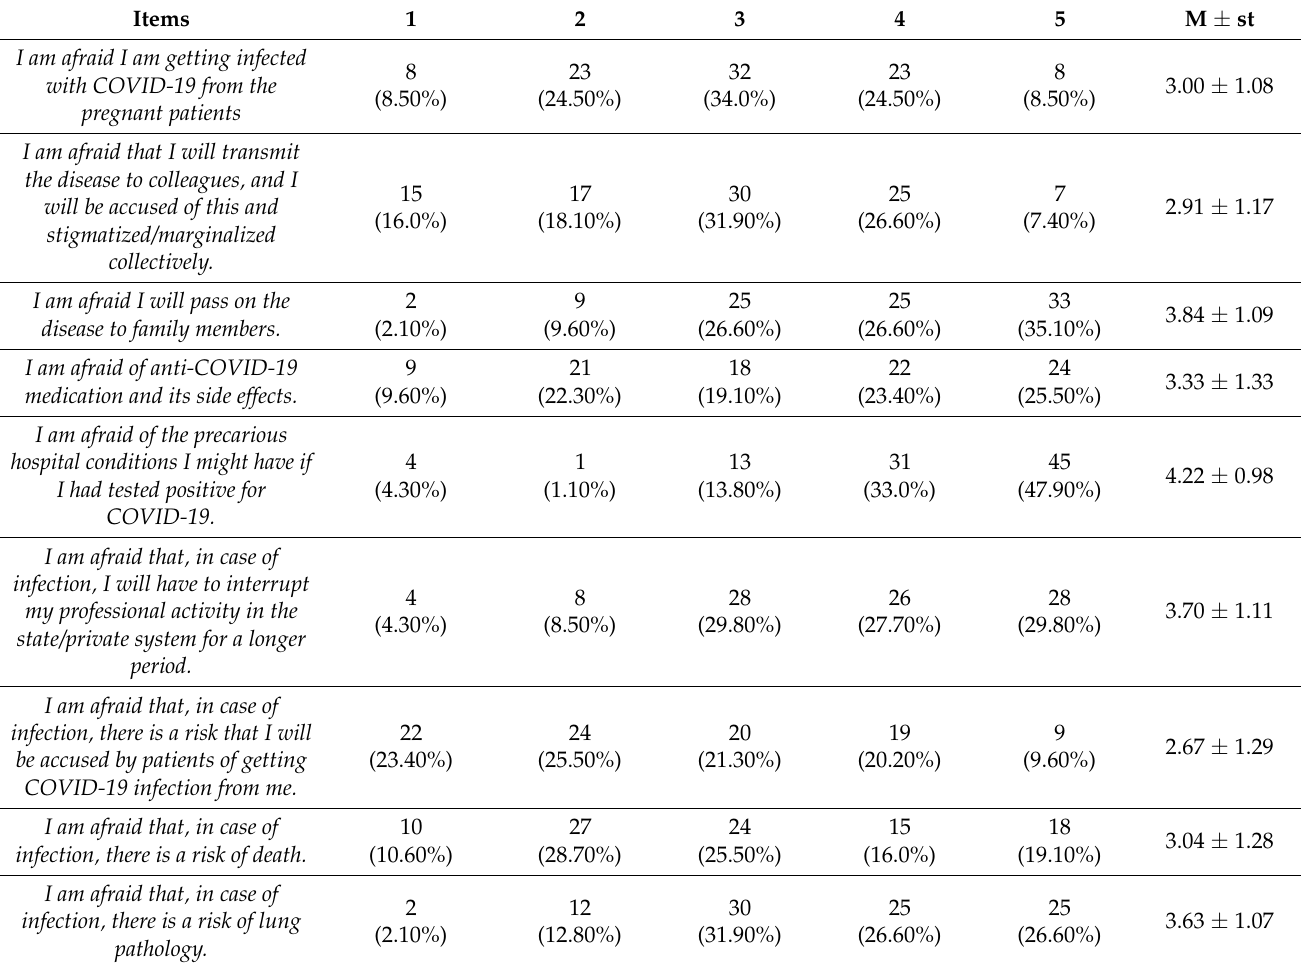
Table 8. The distribution of questions regarding the fear of contagion, hospitalization, and infection side-effects 1 . Items